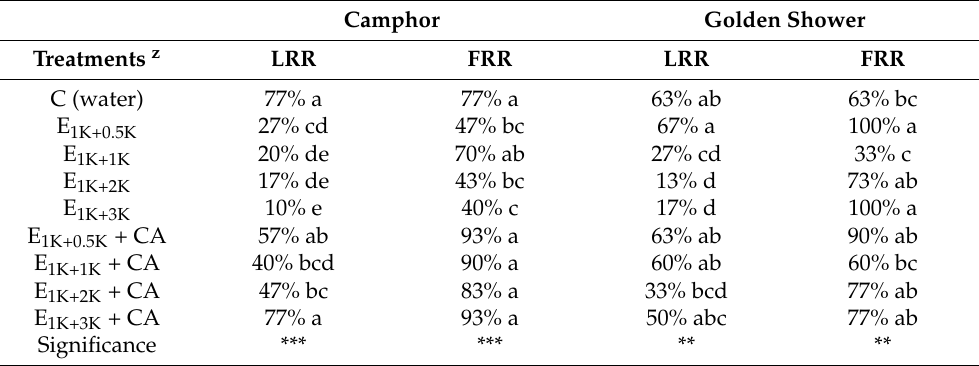
Table 3. LRRs and FRRs of ethephon and/or calcium acetate treatments on camphor and golden shower trees using one-way completely randomized ANOVA. Lowercase letters indicate significant differences among treatments for a given trait ( p < 0.05; LSD test). ns, **, ***: Non-significant or significant at p < 0.01, or 0.001, respectively. z Treatment description is listed in Table 1. Least square difference (LSD) at p < 0.05 significance.